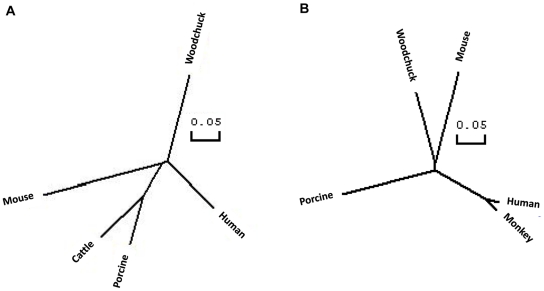
Phylogenetic trees based on the deduced aa sequences of PD-L1 and PD-L2.The phylogenetic tree of PD-L1 (A) and PD-L2 (B) of different mammalian species. The same sequences used in Fig. 1 were considered for the phylogenetic trees.